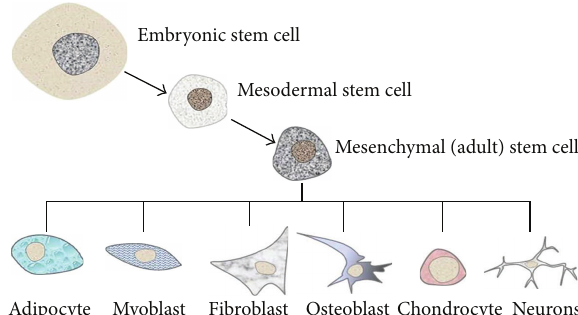
Figure 1: The hierarchical development of mesenchymal stem cells and their differentiation potential into various tissue